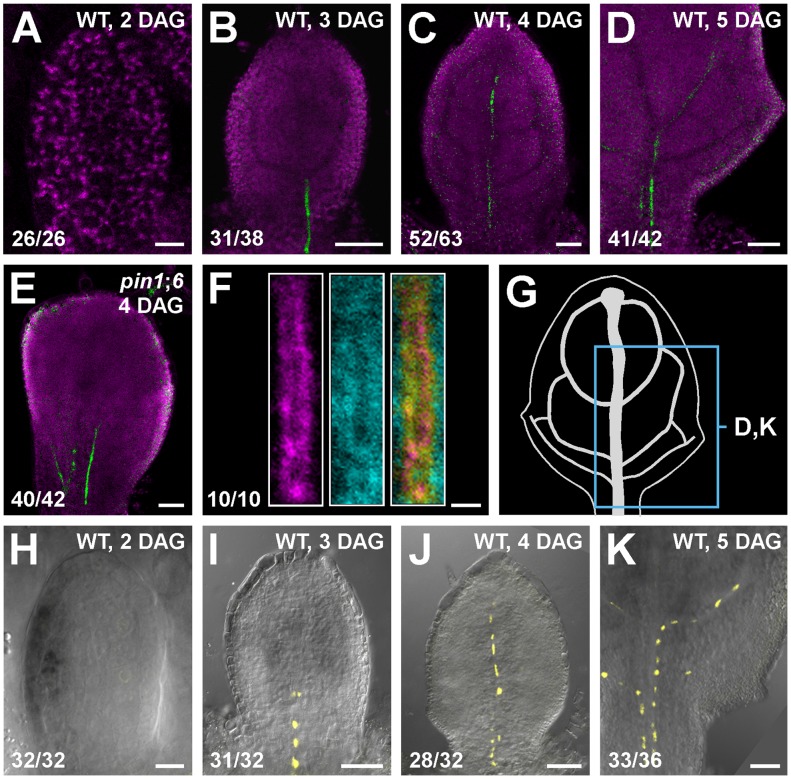
PIN8 expression in leaf development.(A–F,H–K) Top right: genotype, leaf age in days after germination (DAG). Bottom left: reproducibility index. Confocal laser scanning microscopy without (A–F) or with (H–K) transmitted light; first leaves. (A–E) Green: PIN8::PIN8:GFP expression; magenta: chlorophyll. (F) Expression at 3.25 DAG of PIN8::PIN8:GFP (left), staining by ER-Tracker Red (centre) and their overlay displayed with a dual-channel LUT (defined in Figure 2) (right). (G) 5-DAG first leaf illustrating positions of close-ups in (D) and (K). (H–K) PIN6::YFPnuc expression. Bars: (A,H) 10 µm; (B–E,I–K) 50 µm; (F) 2 µm.